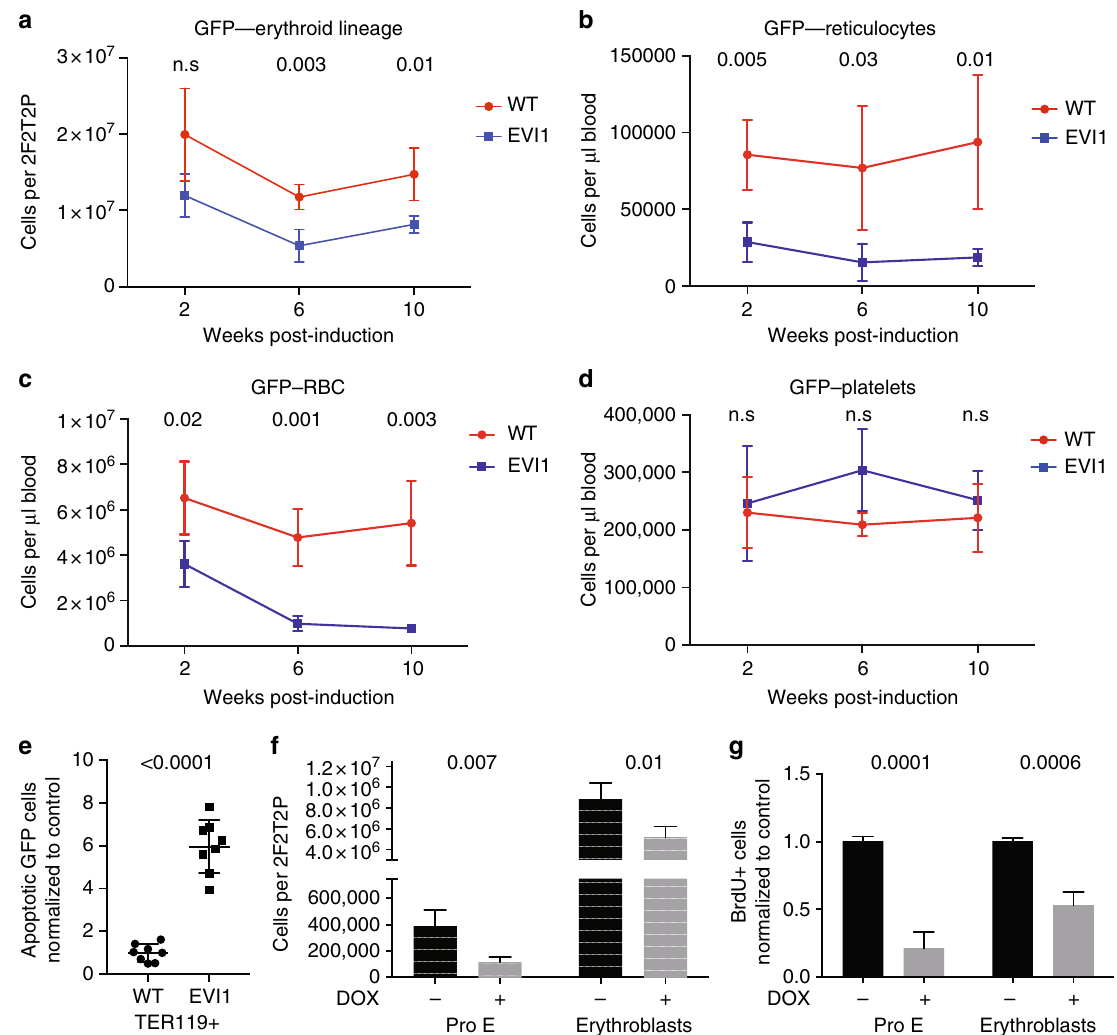
Fig. 2 EVI1 overexpression suppresses erythropoiesis. a Quanti fi cation of erythroid (TER119 + ) cells overexpressing EVI1 (GFP − ) in bone marrow of competitively transplanted recipients harvested 2, 6, or 10 after DOX induction. (WT n = 4 mice, EVI1 n = 4 mice at each time point, total n = 24). b – d Numbers of donor-derived reticulocytes (GFP − , Ter119 + , CD71 + ), erythrocytes (GFP − ,Ter119 + , CD71 − ), and platelets (GFP − , low SSC/FSC, CD41 + ) as indicated at 2, 6, and 10 weeks post induction per microliter of peripheral blood of mice competitively transplanted with DOX-induced Evi1 TO , Rosa26 rtTA mice or WT cells. (WT n = 4 mice, EVI1 n = 4 mice at each time point, total n = 24). e Quanti fi cation of apoptotic (annexin-v + 7AAD − ) erythroid (TER119 + ) cells overexpressing EVI1 (GFP − ) or WT WBM of competitively transplanted recipients, expressed relative to WT GFP − cells from the control transplant, harvested 10 weeks after DOX induction. Each dot represents an individual recipient mouse. (WT = 8 mice, EVI1 = 8 mice). f , g Quanti fi cation of total ( f ) and BrdU-positive ( g ) proerythroblasts (TER119 + low cKit + ), and erythroblasts (TER119 + CD71 + ) in WBM of Evi1 TO/TO Rosa26 rtTA/rtTA mice harvested 48 h with or without DOX induction. (WT n = 4, EVI1 n = 4). For all panels, error bars represent standard deviation; p